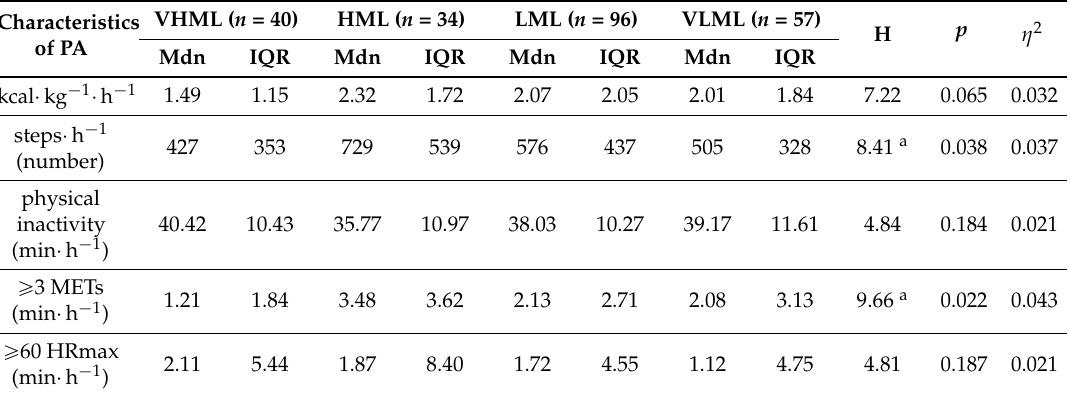
Table 2. Physical activity intensity in participants with various levels of school mental load on